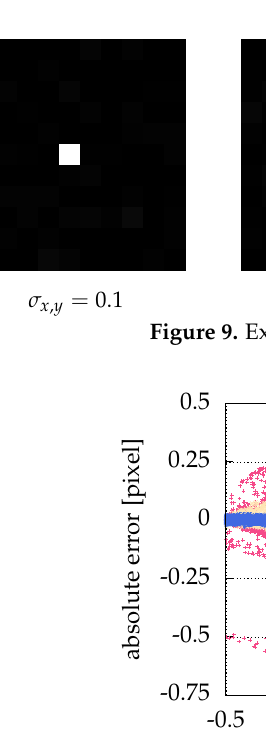
Figure 8. Comparison of different particle sizes: pink ( (cid:4) ) bars for σ { x , y } = 0.1, yellow ( (cid:4) ) for σ { x , y } = 0.5, blue ( (cid:4) ) for σ { x , y } = 1 and green ( (cid:4) ) for σ { x , y } = 2. Missing bars imply that not all particles where correctly detected. The ordinate shows the root mean square error of the distance between detected and real positions. There was a low Gaussian noise with a SNR = 100, and no salt and pepper noise. The statistics/simulation was done with images containing 10,000 particles.